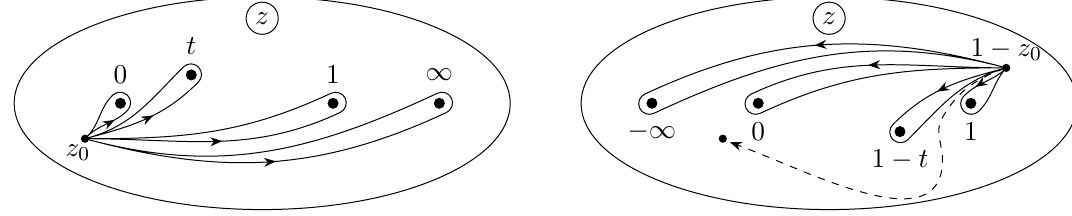
Figure 3 . Transformation of loops under z 7! 1 (cid:0) z